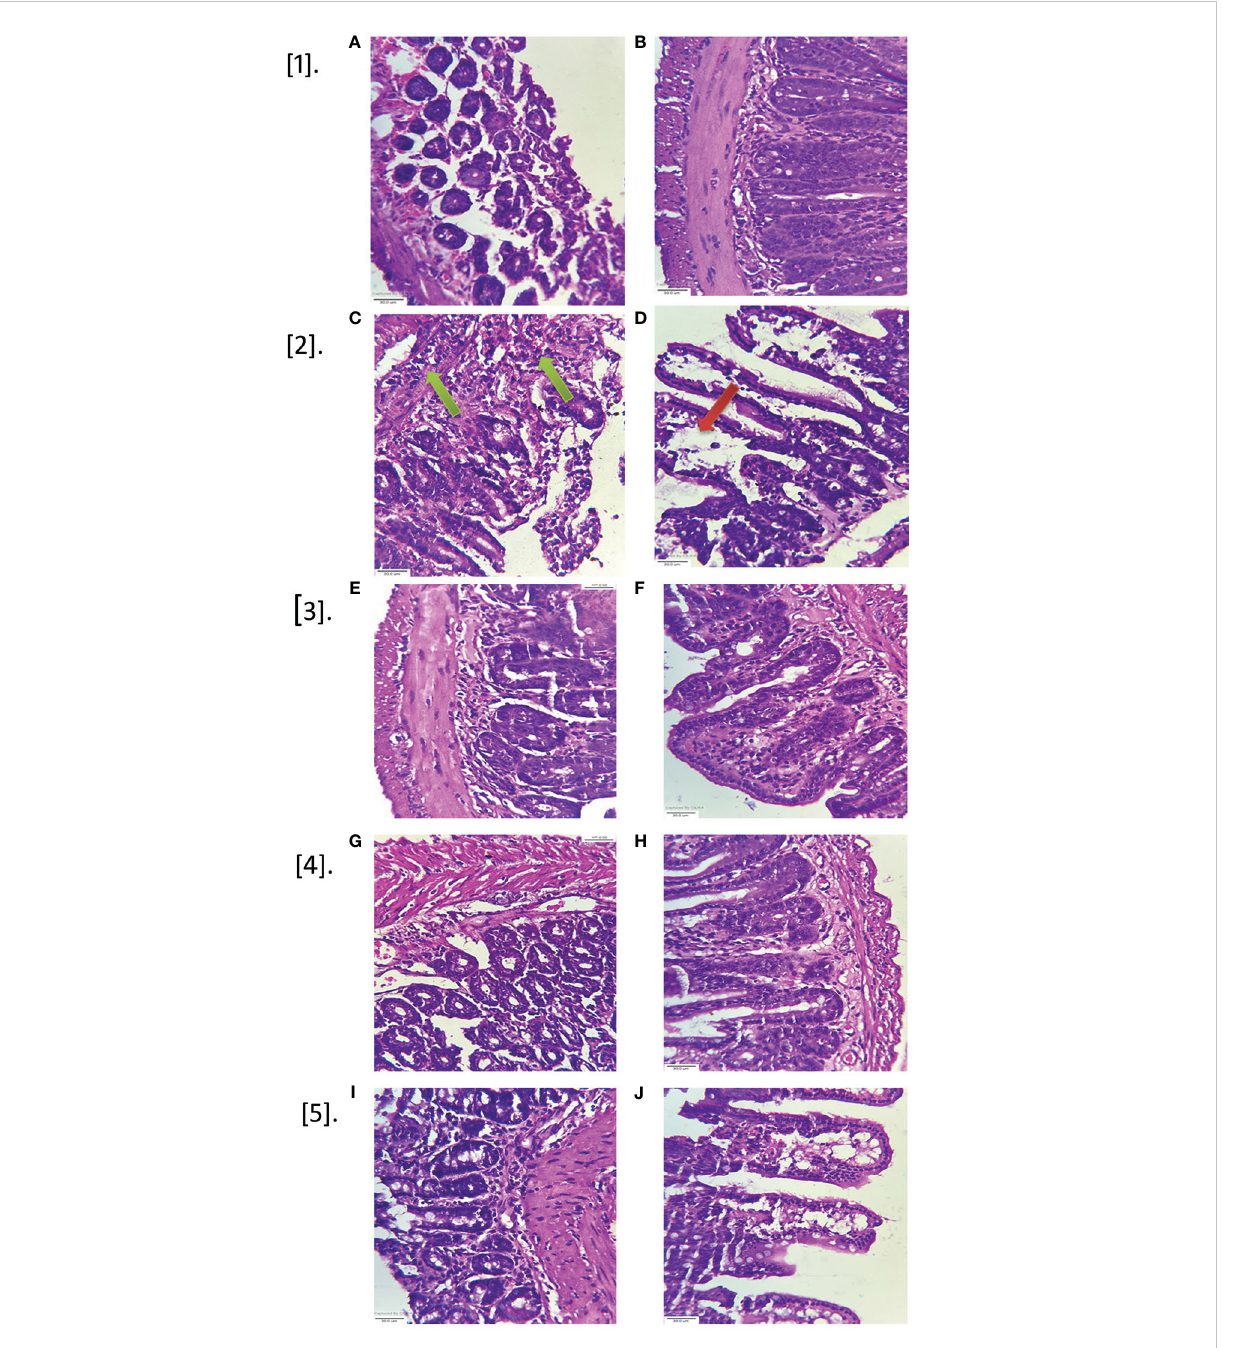
FIGURE 14 Histopathological analysis of mice ileal loops. Intestinal tissues of mice ileal sections stained with hematoxylin, eosin and observed at 40x magni fi cation (scale bar=30µm). Green arrows represent in fl ammation in submucosa; red arrows represent mucosal layer degeneration and